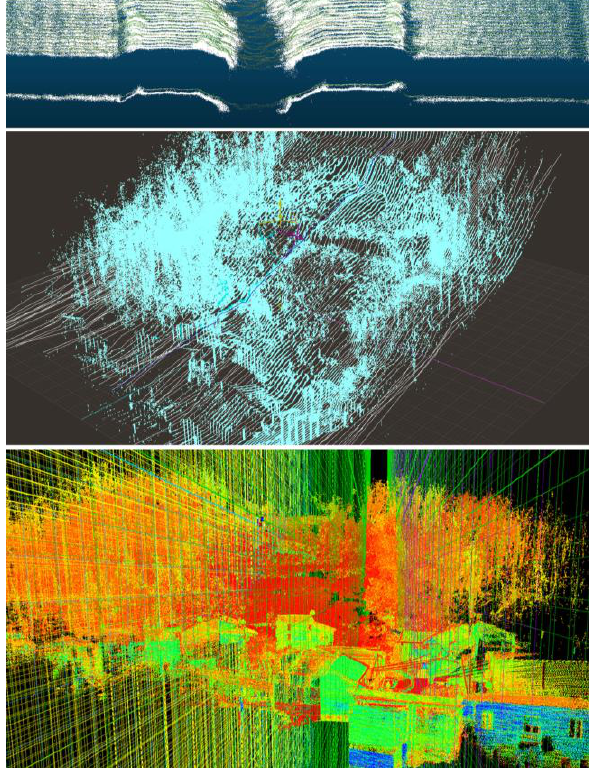
Figure 7. Extraction of sections and manual modeling starting from the points of the point cloud acquired in the